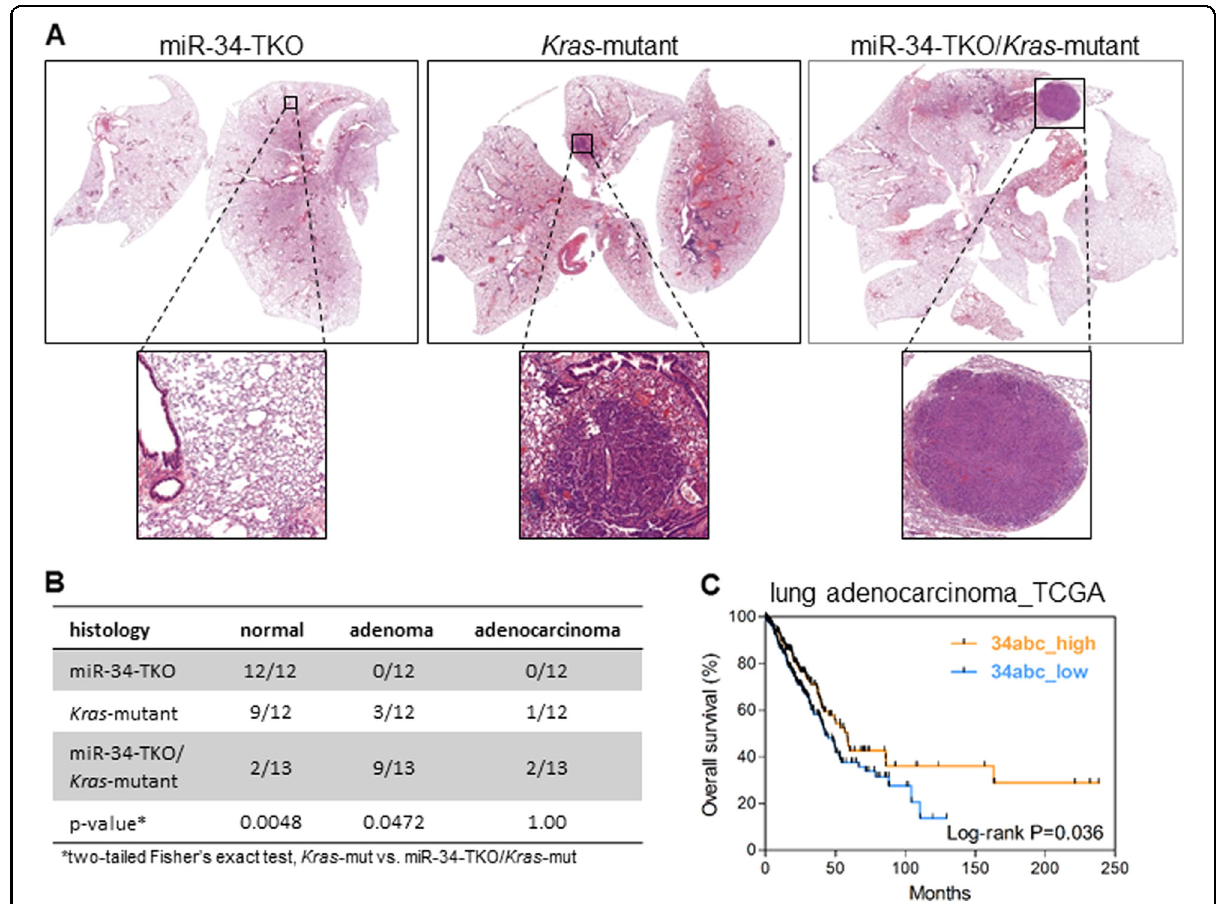
Fig. 6 MiR-34-triple knockout enhances mutant Kras -driven lung tumorigenesis. a Histologic sections of lung tissues from the miR-34-triple knockout (TKO), Kras -mutant ( Kras G12D ), and miR-34-TKO/ Kras -mutant mice. Lung tissue sections from each cohort were stained with hematoxylin and eosin and photographed. Magni fi cations of the adenomas are shown in the insets. b Lung histopathology of miR-34-TKO, Kras -mutant, and miR-34- TKO/ Kras -mutant mice. P -values were determined using two-tailed Fisher ’ s exact tests. c Kaplan – Meier plot of lung adenocarcinoma patients from TCGA data. Patients were divided into two groups (high and low) based on the total miR-34 (miR-34a, miR-34b, and miR-34c) expression levels. P - values were determined with the log-rank